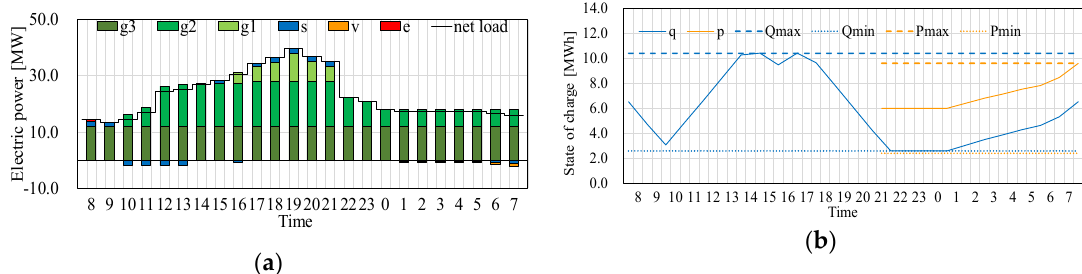
Figure 3. ( a ) Operation schedule for forecasted net load in Case 1; ( b ) state-of-charge (SOC) level in Case 1.